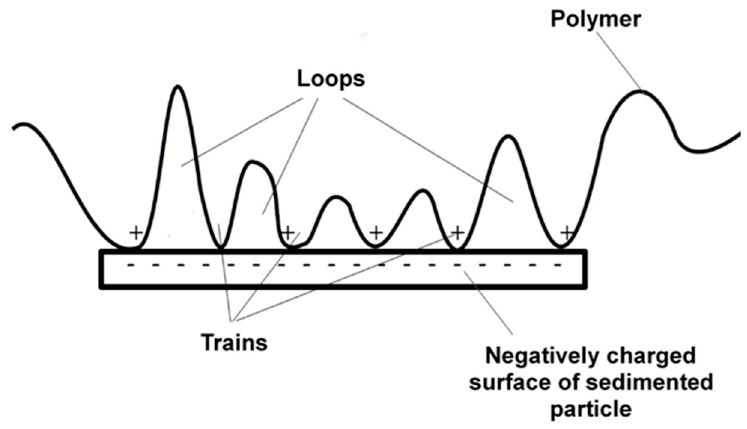
Figure 3. Polymer adsorption on surface of solid